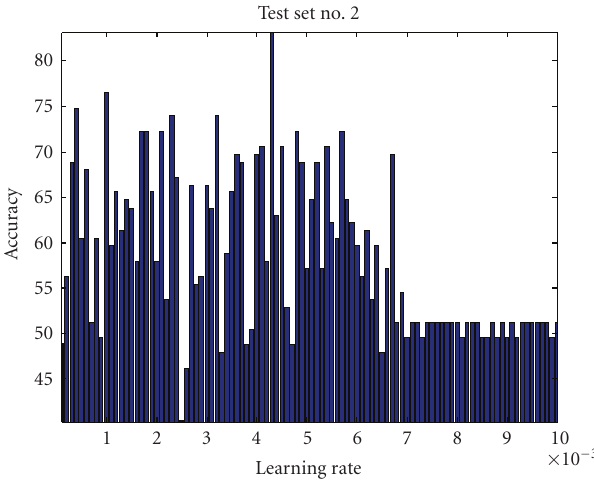
Figure 5: Learning rate impact on accuracy for test set number 2 (all other parameters were kept constant).